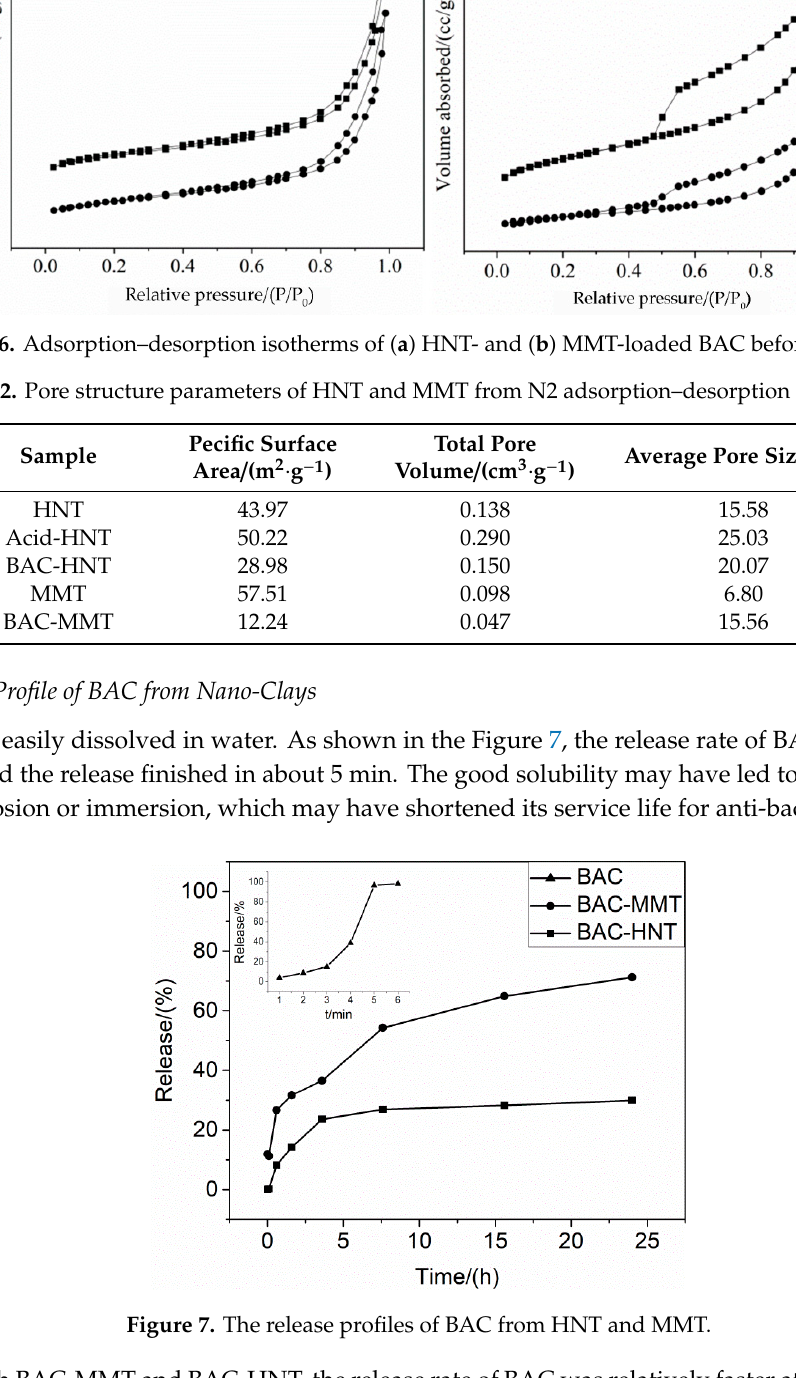
Figure 7. The release profiles of BAC from HNT and MMT.